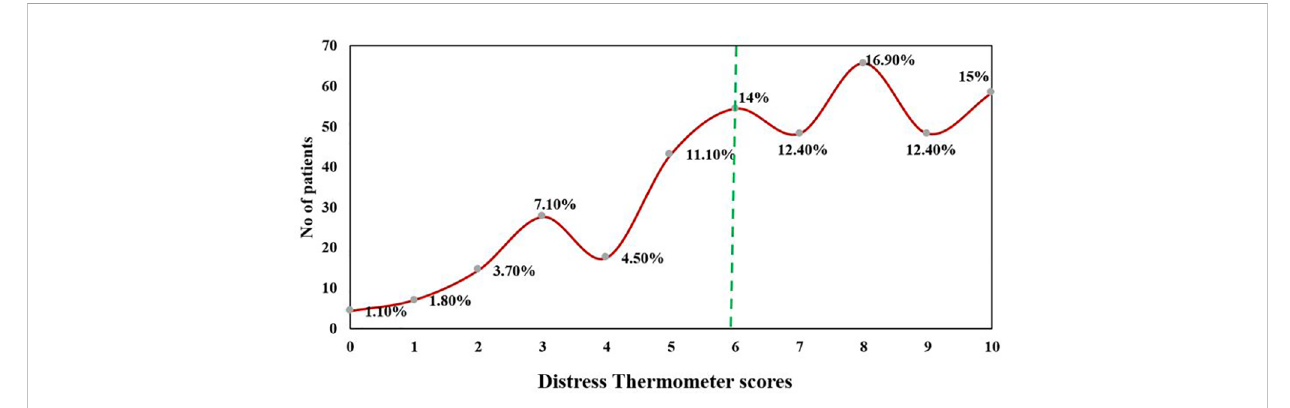
FIGURE 3 The frequency distribution of DT score under and above DT cutoff scores